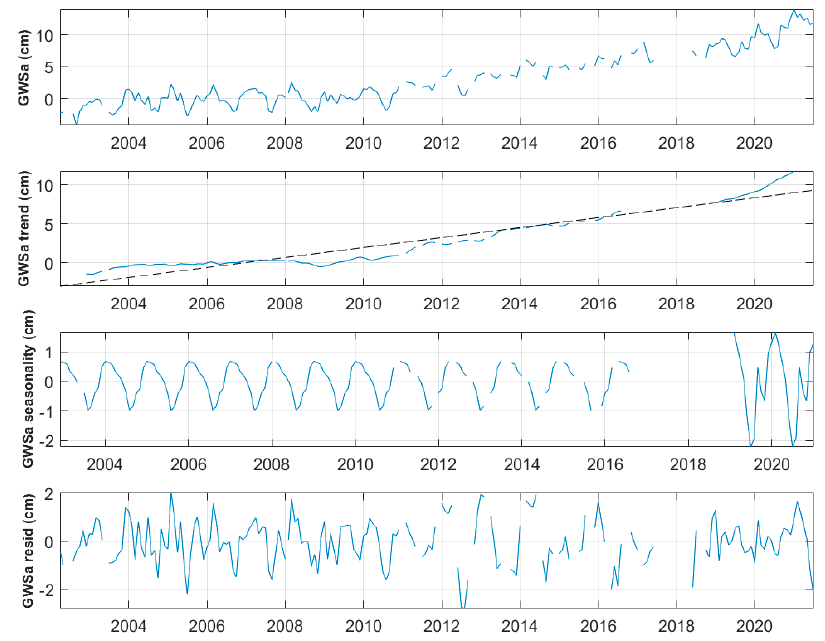
Figure 6. Decomposed GWSa data for the Iullemeden basin.